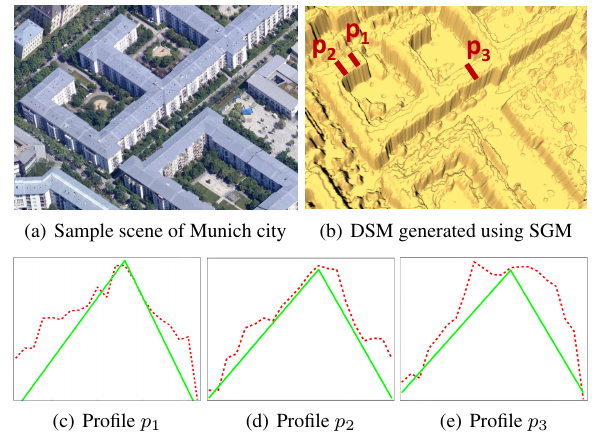
Figure 1: DSM of a sample scene of city Munich and the pro- files of some building roofs for better interpretation of the DSM